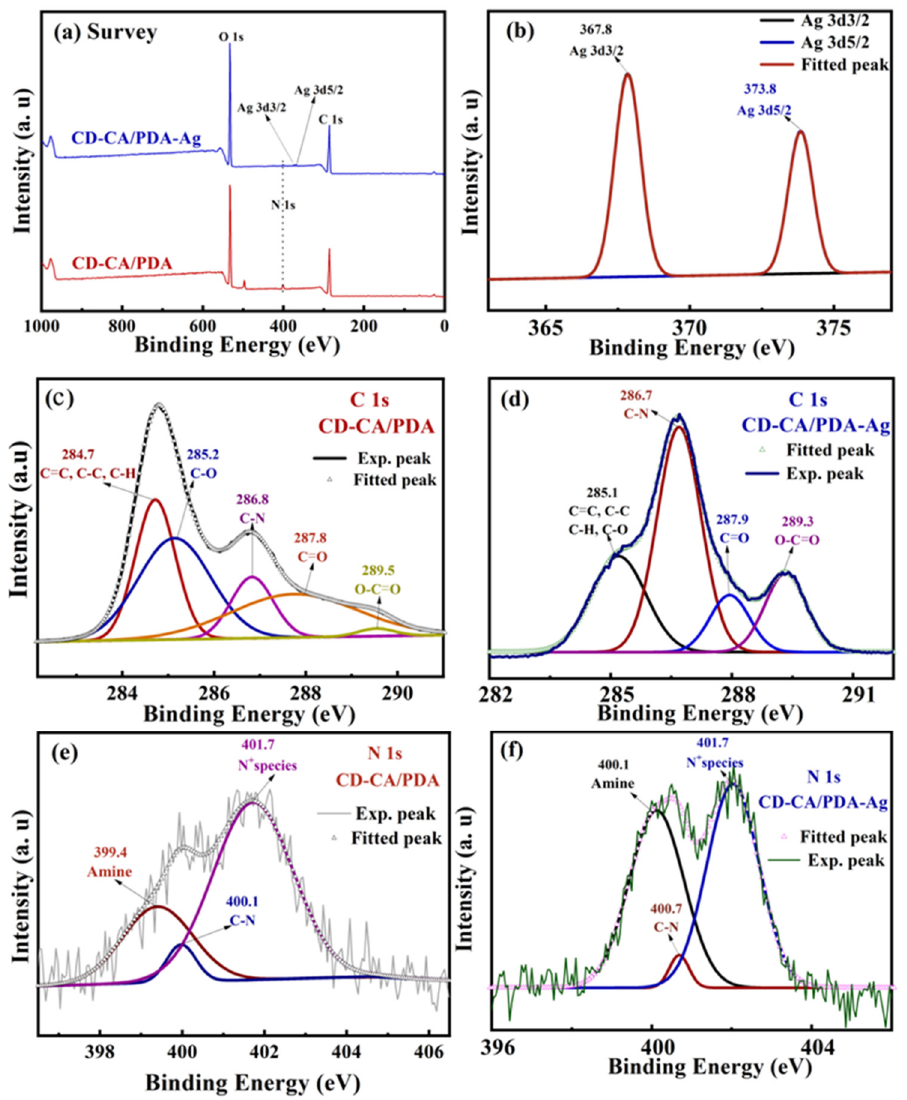
Figure 3. XPS survey spectra of CD-CA/PDA and CD-CA/PDA-Ag ( a ). High-resolution spectra of Ag 3d peaks for CD-CA/PDA-Ag ( b ). High-resolution spectra of C 1s peaks for CD-CA/PDA ( c ) and CD-CA/PDA-Ag ( d ). High-resolution spectra of N 1s peaks for CD-CA/PDA ( e ) and CD-CA/PDA-Ag ( f ).